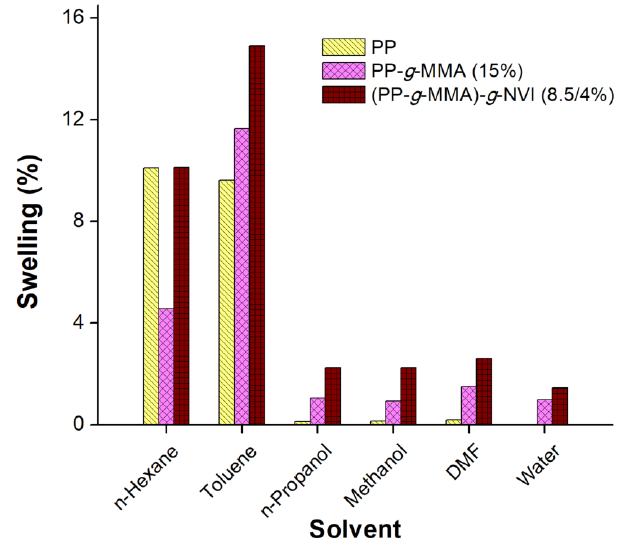
Figure 7. Swelling of the films in different solvents.